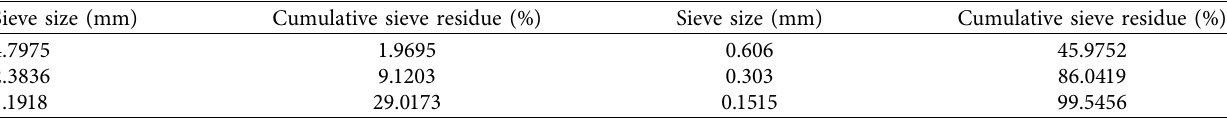
Table 6: River sand grading.